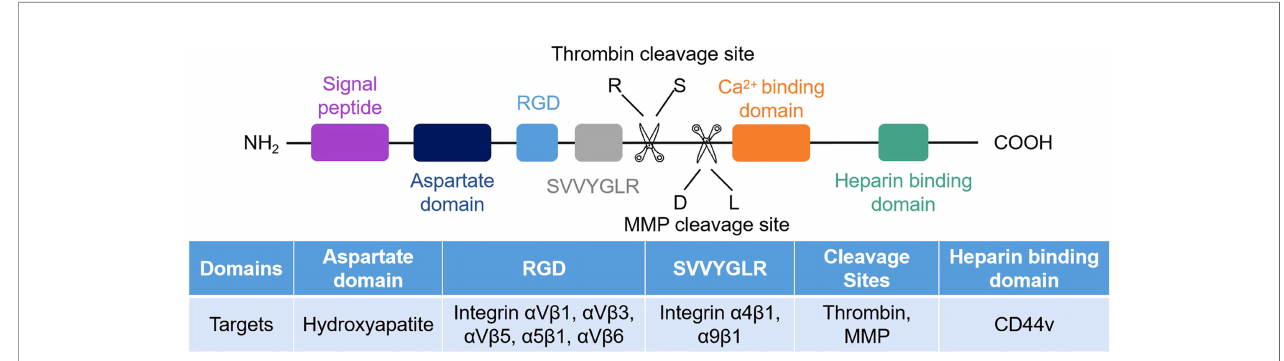
FIGURE 1 | Schematic of the human OPN protein structure. There are seven exons encoded in human OPN protein. CD44 and integrins are the receptors of OPN, and their corresponding binding regions are